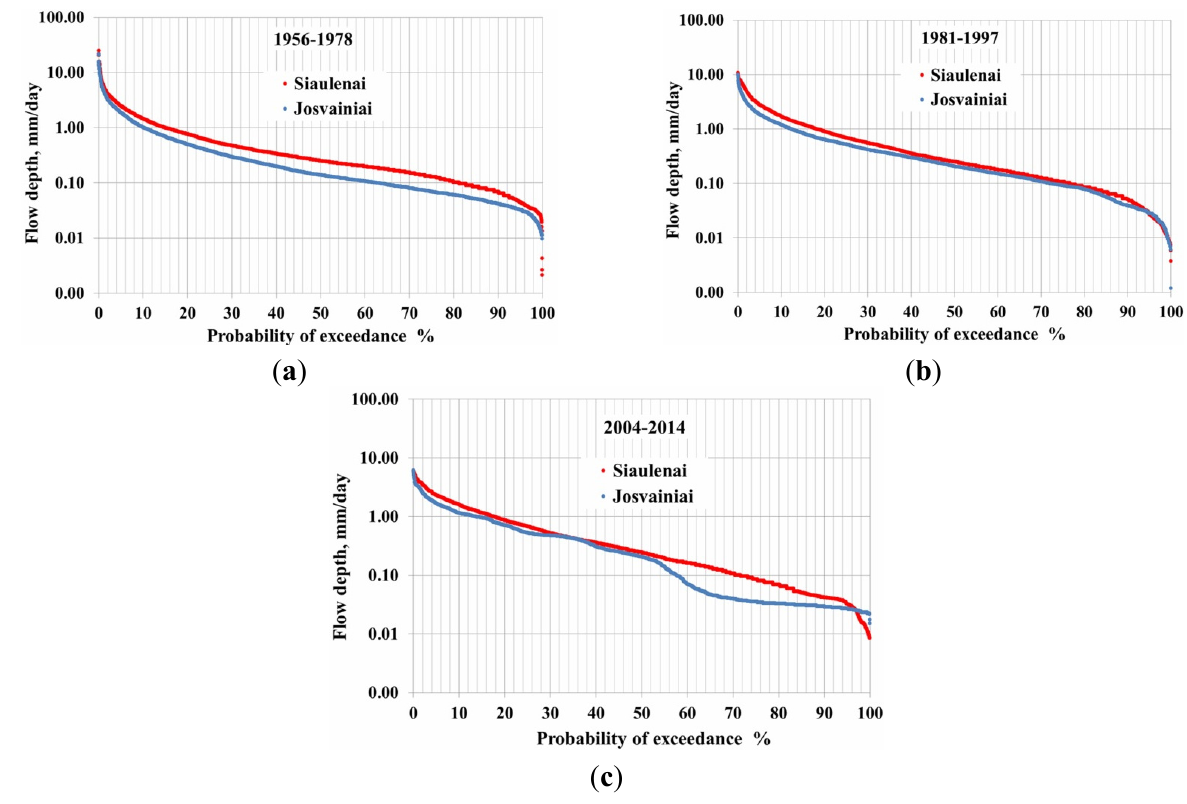
Figure 5. Comparison of FDCs in each period between two gauging stations—Siaulenai and Josvainiai. ( a ) The first period (1956–1978); ( b ) The second period (1981–1997); ( c ) The last period